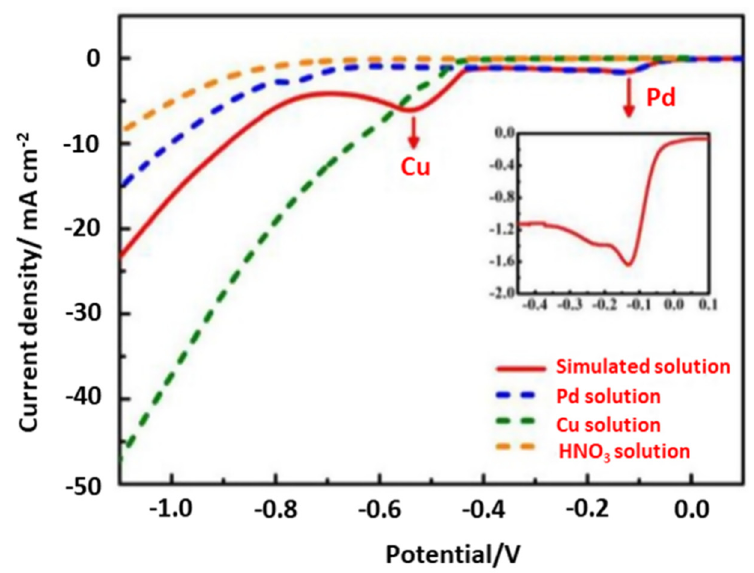
Figure 4. The linear sweep voltammogram (LSV) curves of the simulated solution, a Pd 2+ solution, Ca u 2+ solution, and HNO 3 . Reproduced with permission [62] . Copyright 2020, Elsevier.